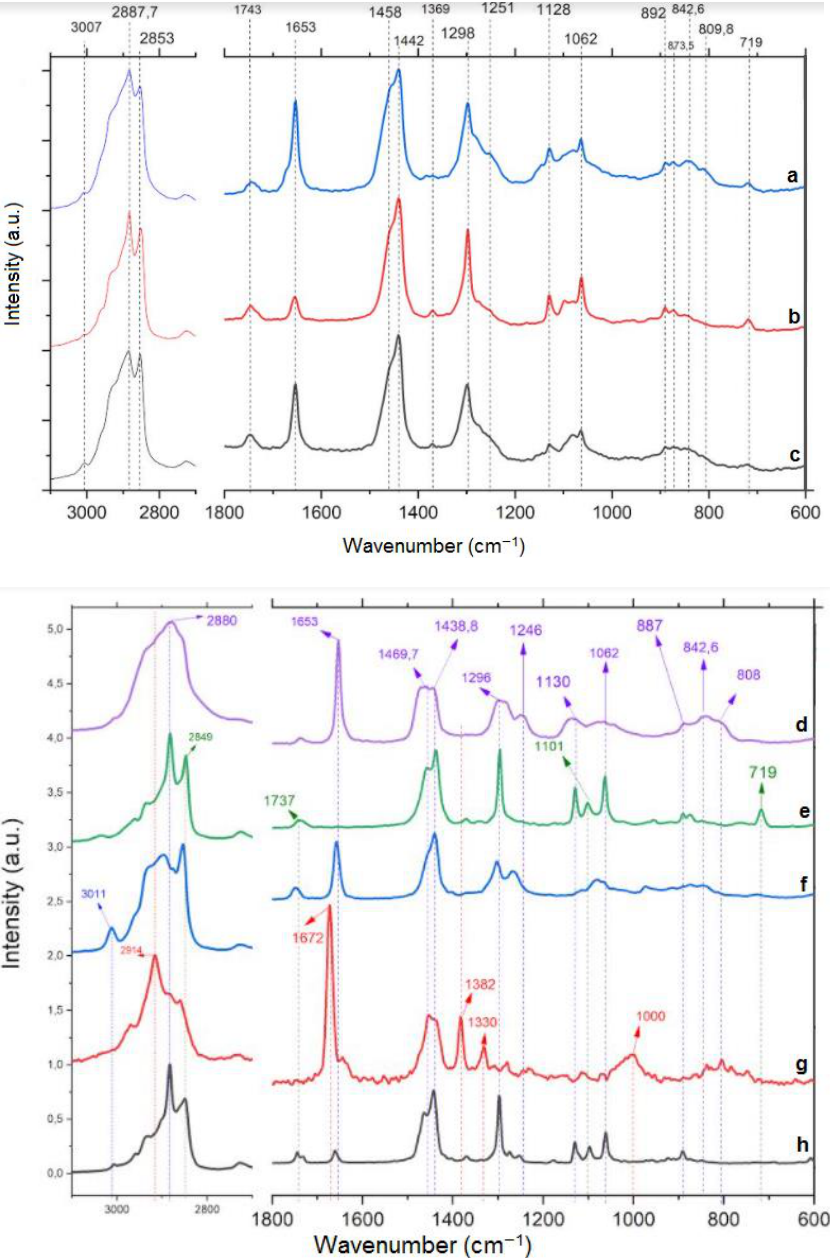
Figure 5. FT-Raman spectra of physical mixture of OF12 ( a ), lyophilized OF12B ( b ), lyophilized OF12 ( c ), Tween 80 ( d ), Phospholipon ® 80H ( e ), sesame oil ( f ), Palmarosa essential oil ( g ), and cocoa butter ( h ).